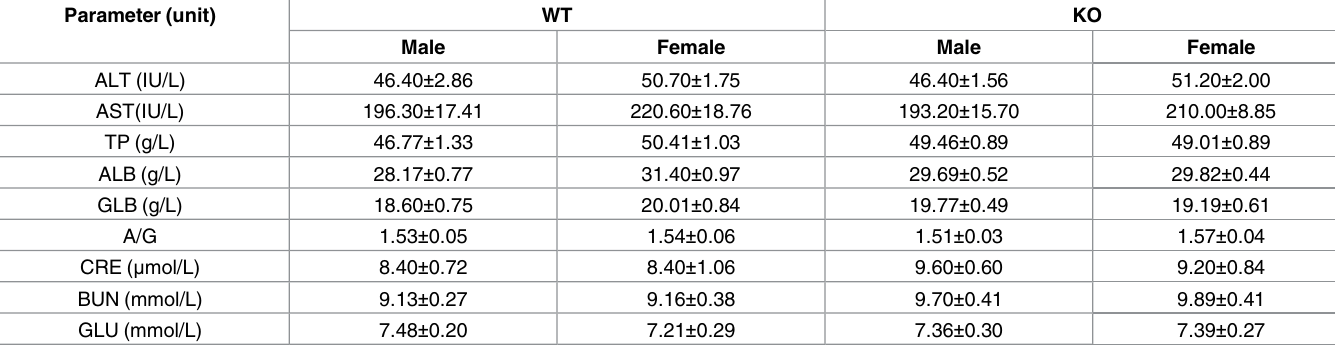
Table 6. Serum biochemical values of the control and model groups.